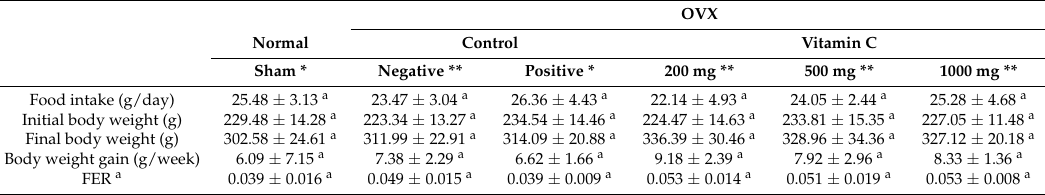
Table 1. Body weight gain and food intake by experimental group.